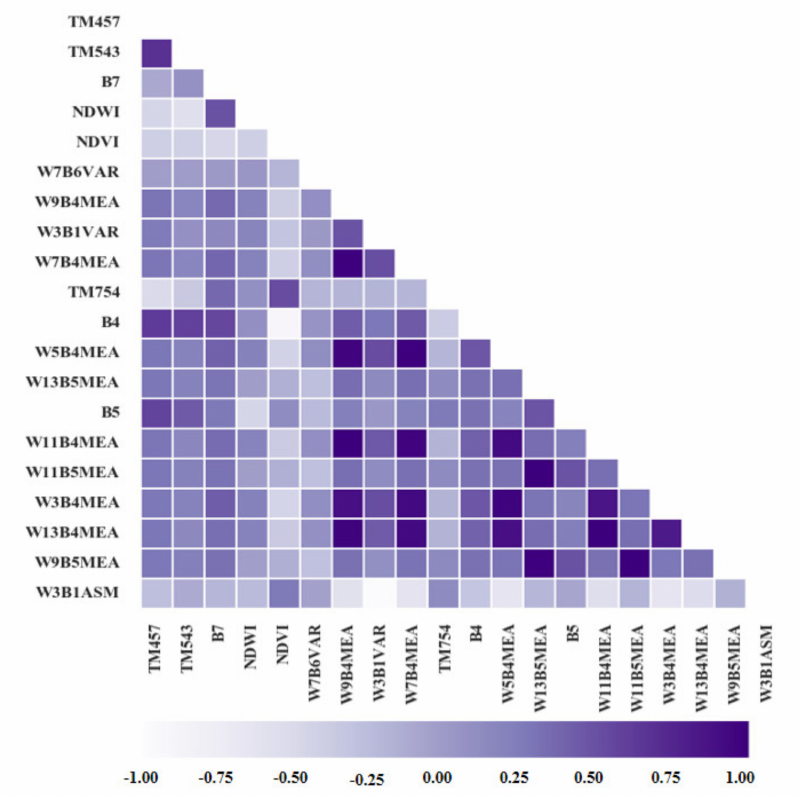
Figure 13. Autocorrelation of the top 20